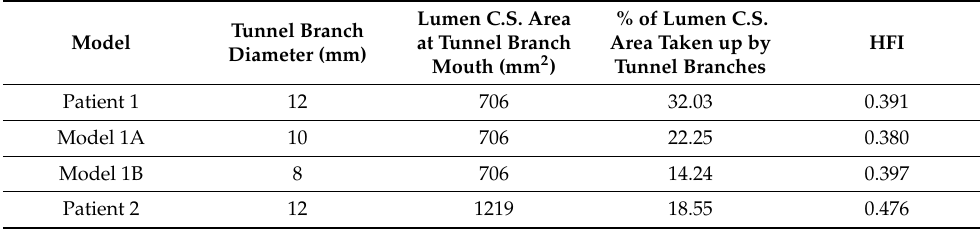
Table 2. Geometric dimensions and helical flow index (HFI) for different models, where Patient 1 and Patient 2 have different overall geometries, while Patient 1, models 1A and 1B have the same aorta geometry but different tunnel branch diameters. C.S. stands for